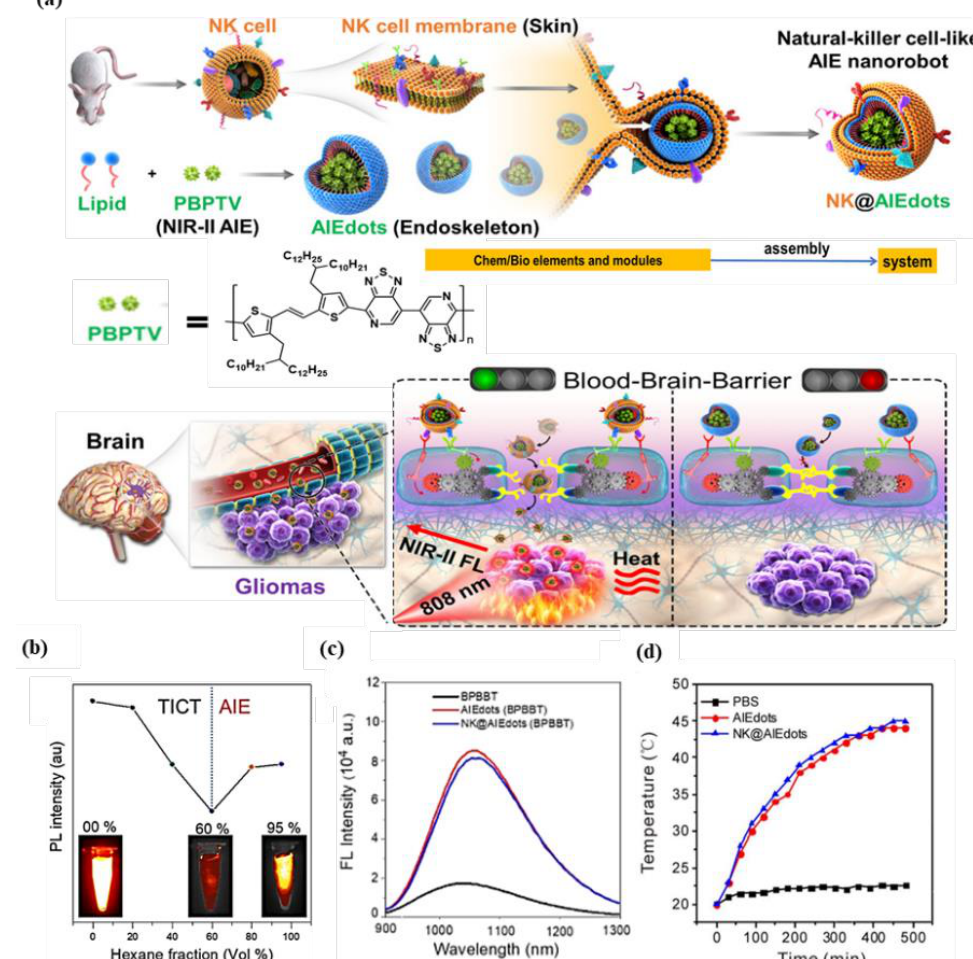
Figure 3. ( a ) Schematic illustration of the preparation and assembly process of NK-cell-mimic AIE nanoparticles (NK@ AIEdots); ( b ) plot of fluorescence intensity of PBPTV in dichloromethane/hexane mixtures; ( c ) fluorescence spectra of BPBBT, AIEdots (BPBBT), NK@AIEdots (BPBBT) in water ; ( d ) photothermal effect of PBS, AIEdots, and NK@AIEdots; Reprinted with permission from Ref.